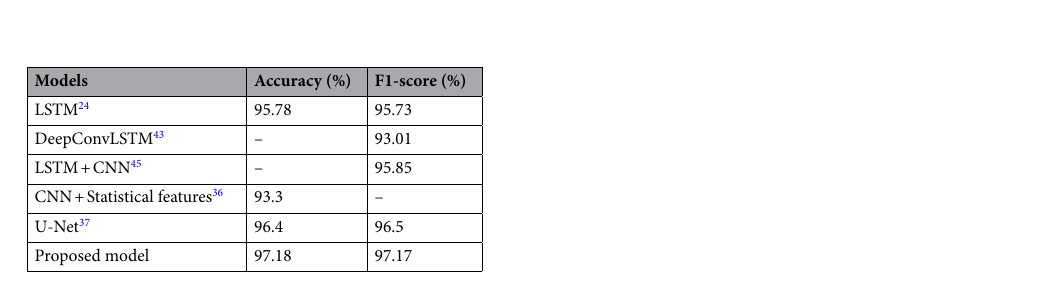
Table 4. Performance comparison of the proposed model with the model using classical convolutions on the WISDM dataset.